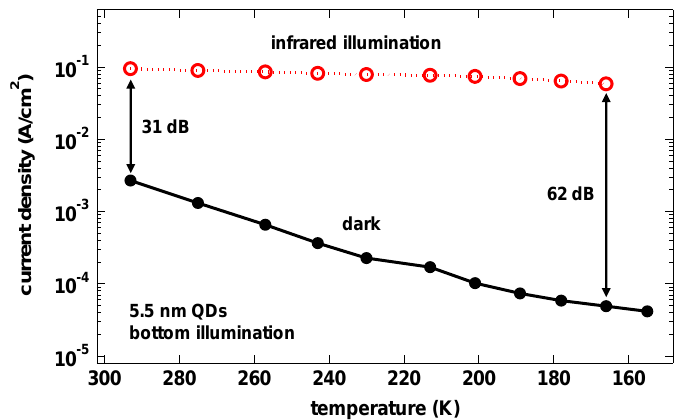
Figure 12. Dark and photocurrent vs. photodetector temperature, indicating an increasing current ratio with lowering the operating temperature.